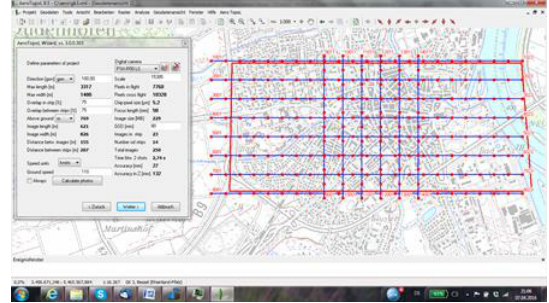
Figure 1: Mission plan of the 8 cm mission made with AeroTopoL FMS